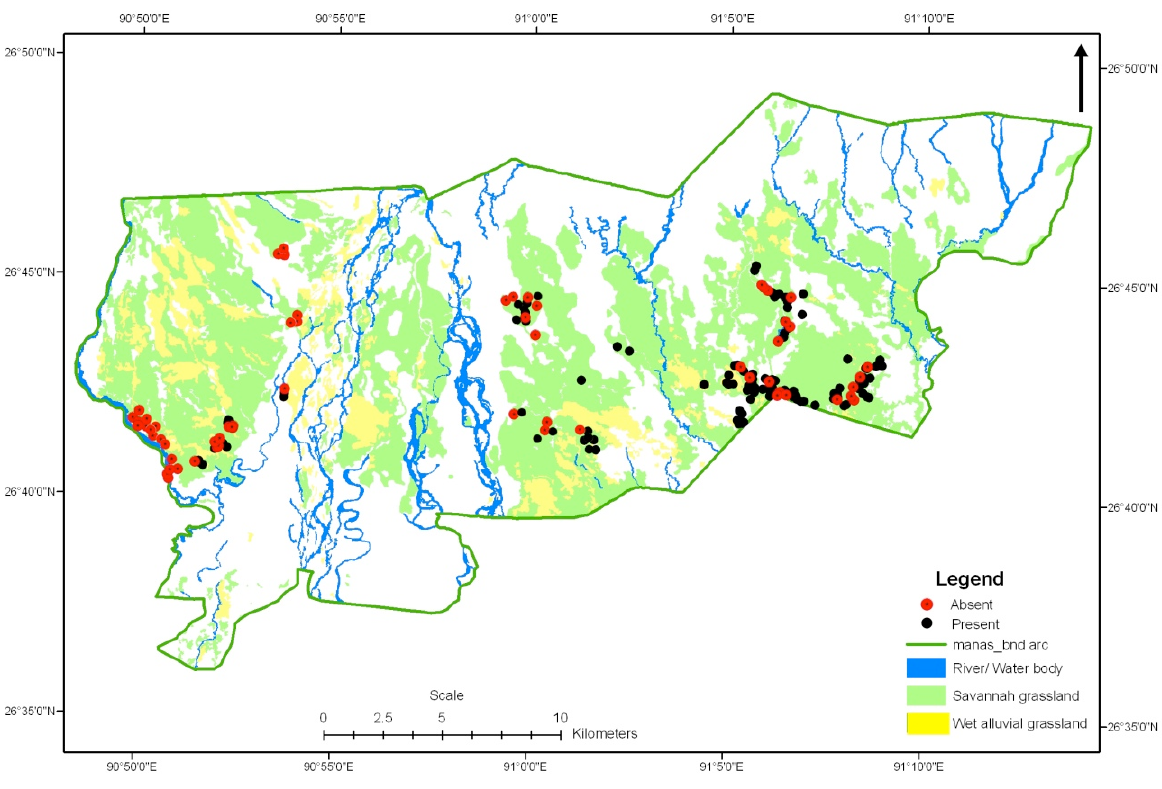
Figure 2. Map of Hispid Hare distribution within Manas National